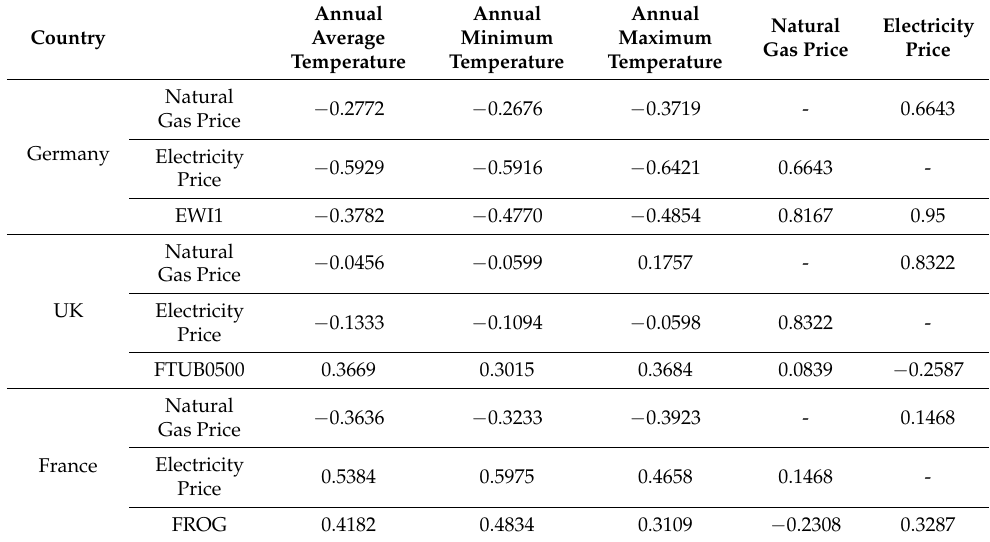
Table 1. Spearman correlation between annual temperature, energy price and some financial instru- ments in Germany, UK and